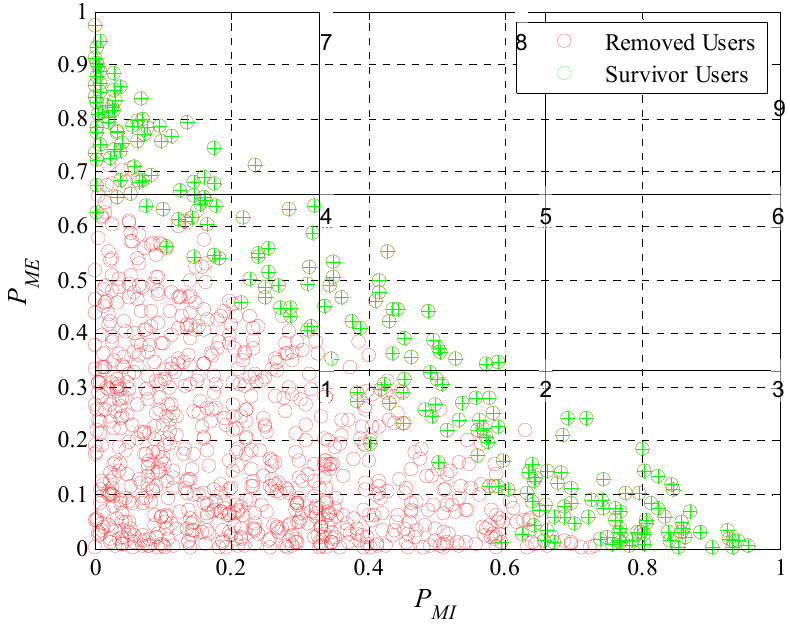
Figure 21. Graphical representation of user motivation levels on a Cartesian plane divided into subgroups when r desired = 0.8 .